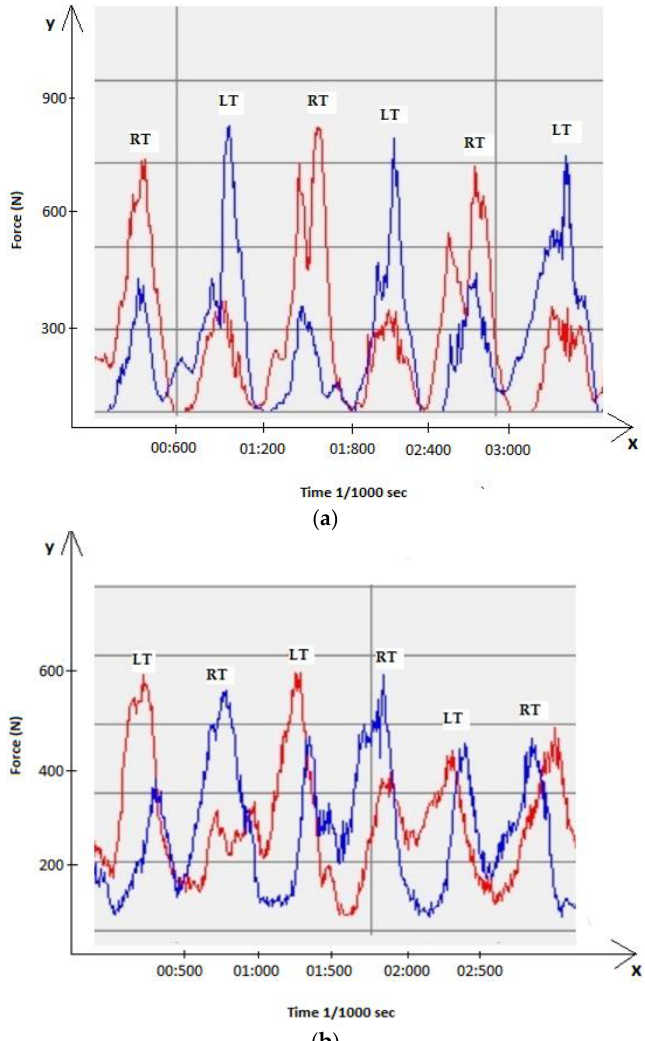
Figure 3. ( a ) Maximal pressure forces on left (red line) and right (blue line) foot during AS, LT — left turn, RT — right turn; ( b ) maximal pressure forces on left (red line) and right (blue line) foot during IS, LT — left turn, RT — right turn.